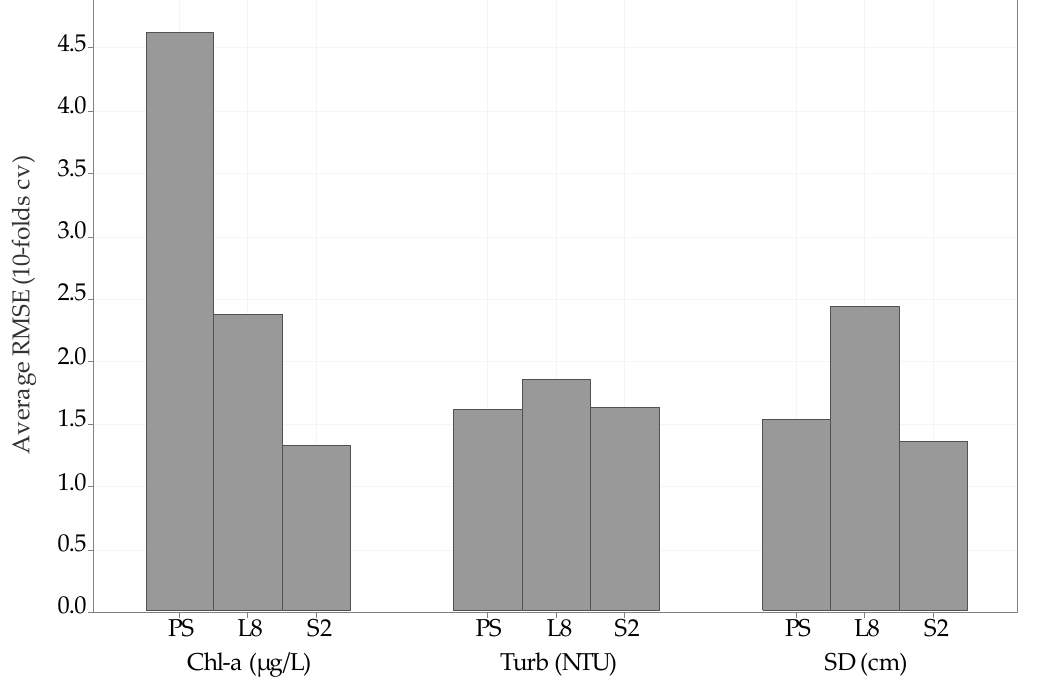
Figure 6. Average RMSE values in the 10-fold cv of the parameters with PS, Landsat-8, and Sentinel-2.